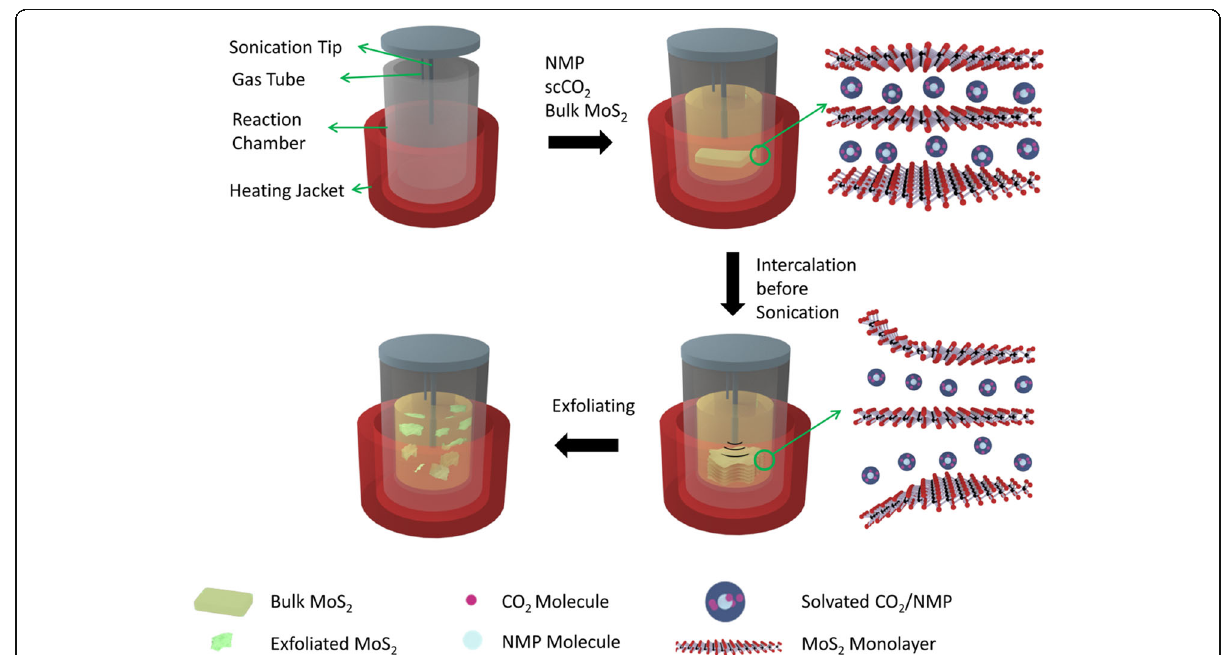
Fig. 1 A schematic showing the exfoliation procedure and the concerted intercalation of supercritical CO 2 and